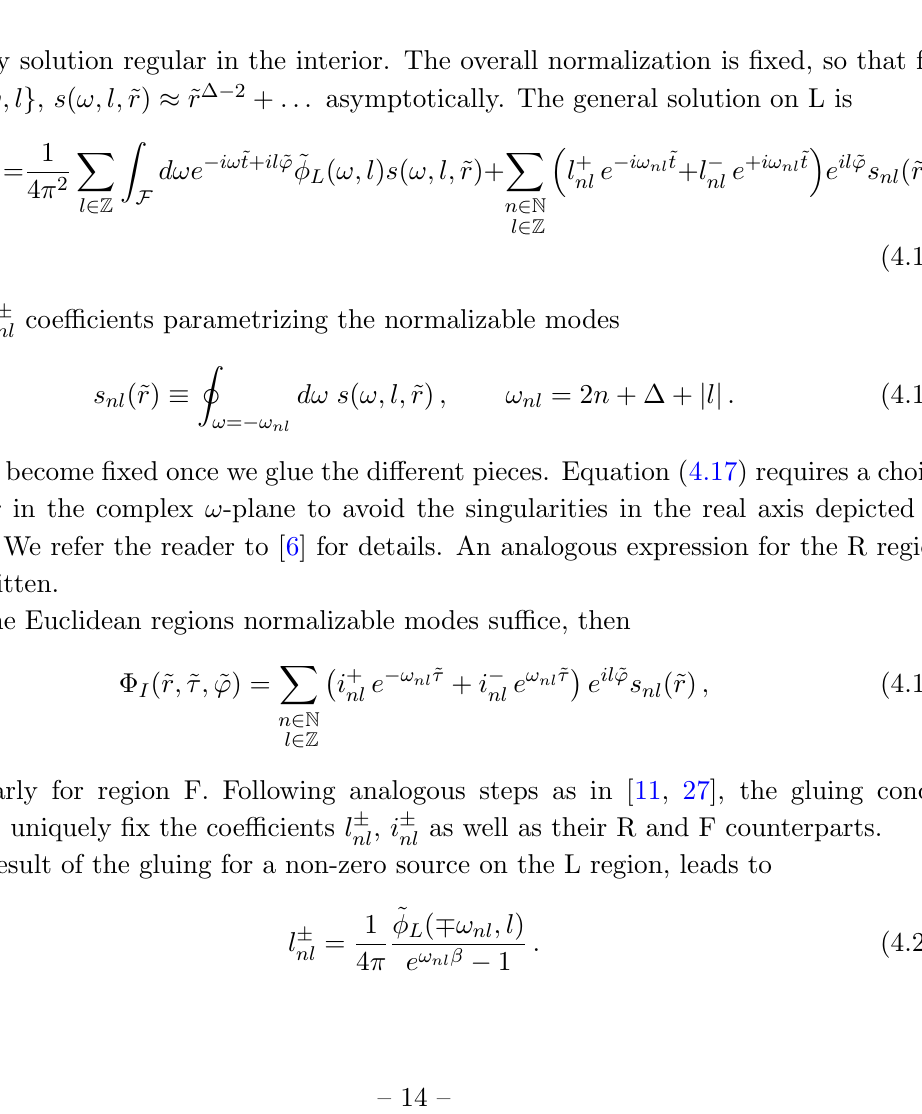
Figure 6 . (a) SK contour for Thermal AdS. The Euclidean pieces have di(cid:11)erent extensions: (cid:27) for I and (cid:12) (cid:0) (cid:27) for F . (b) Dual real time Thermal AdS geometry. Notice that the L and R regions are only connected through the Euclidean sections. The pieces are ordered as dictated by the contour order in (cid:12)gure